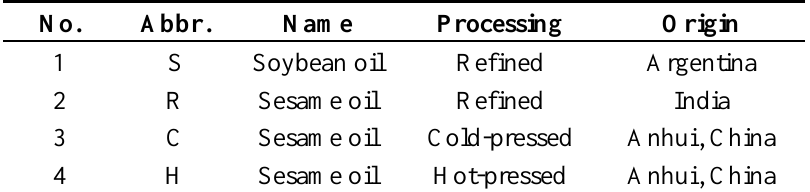
Table 1. Oil sample information.